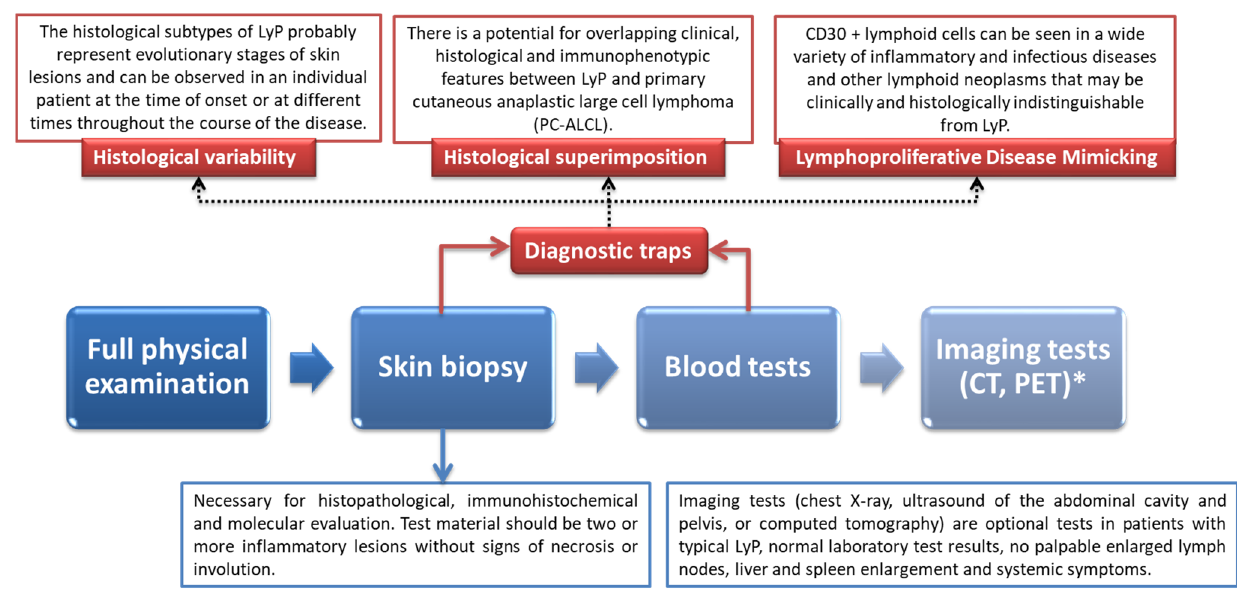
Figure 2. Proper diagnostic procedure in case of suspected lymphomatoid papulosis.